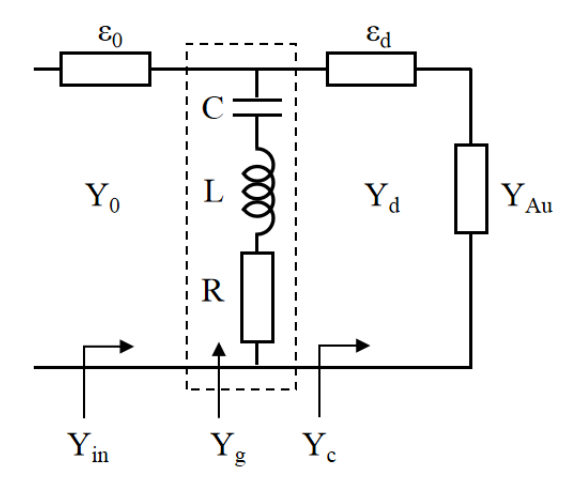
Figure 2. Equivalent circuit model for the graphene metasurface-based